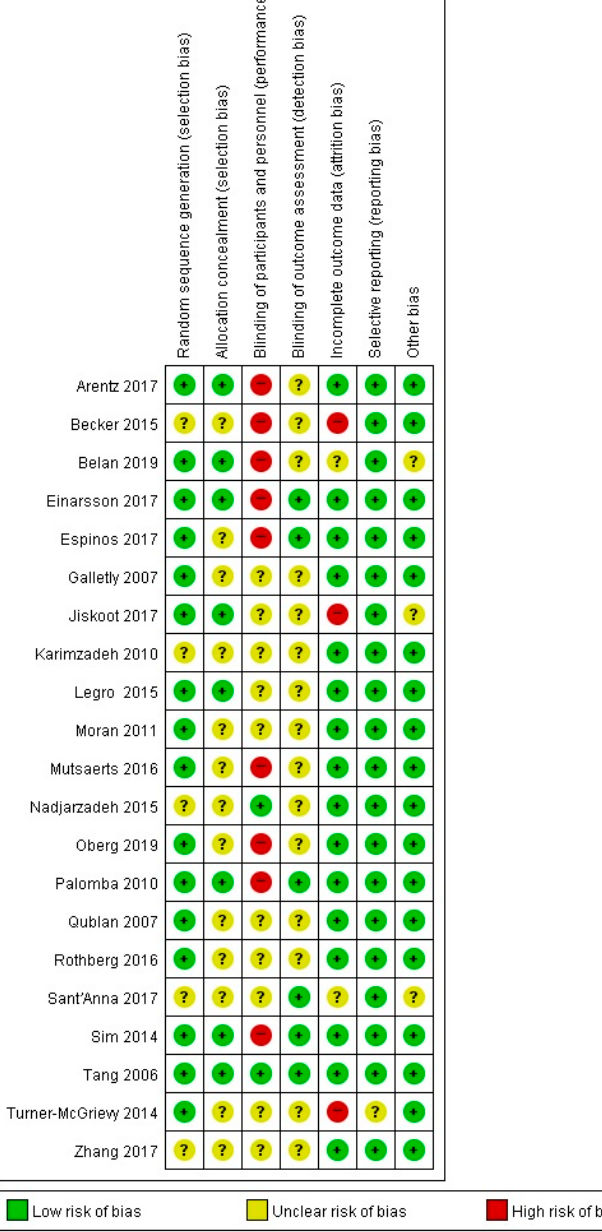
Figure 2. Risk of bias graph.